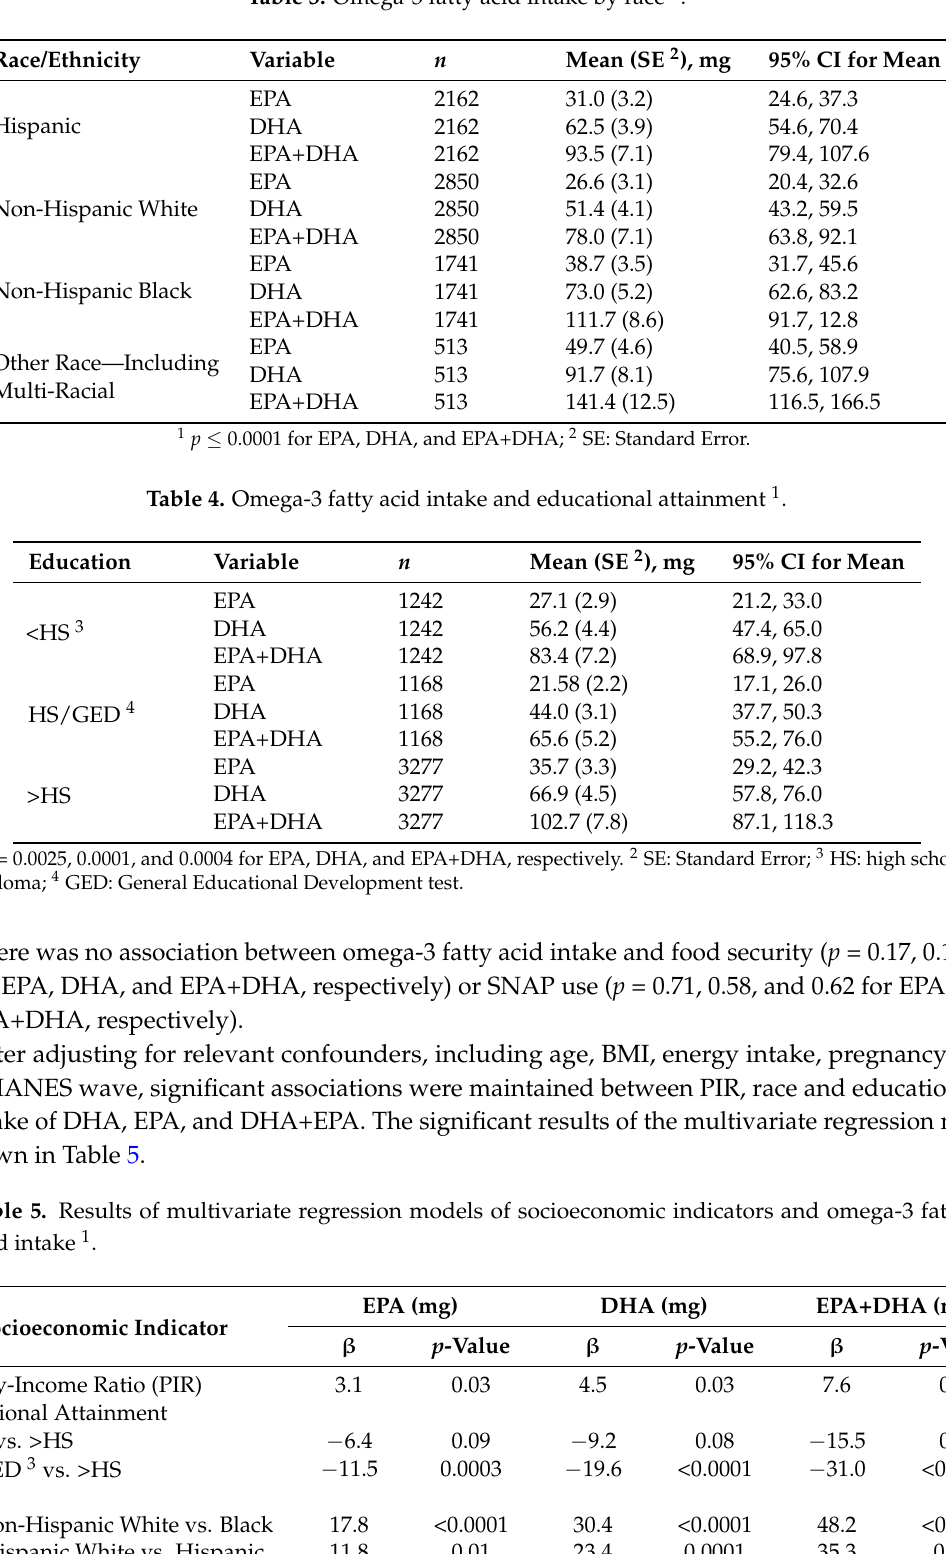
Table 3. Omega-3 fatty acid intake by race 1 .